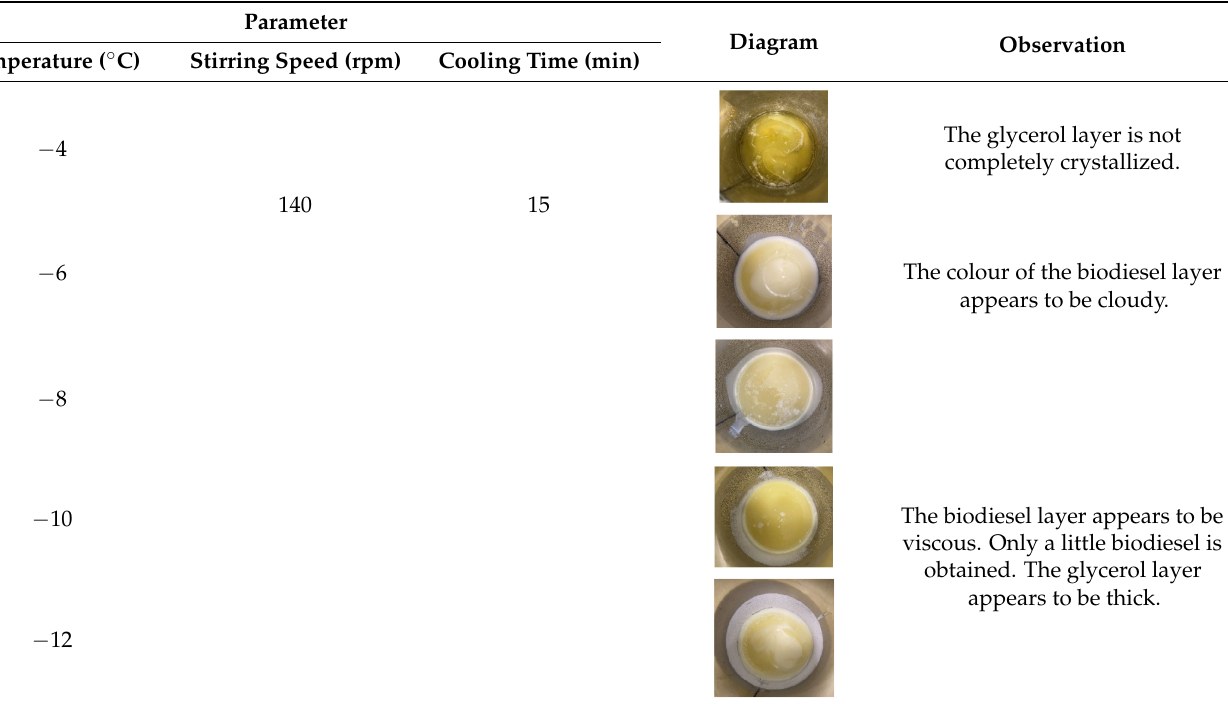
Figure 3. FAME purity against coolant temperature. Table 1. Observation for the effect of coolant temperature in